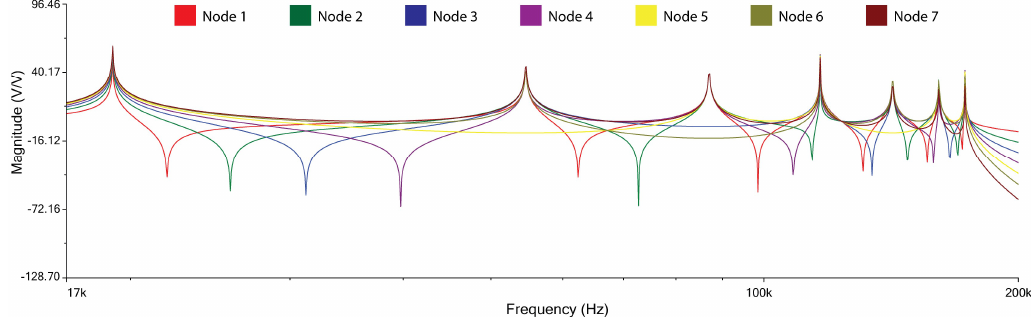
Figure 8. Magnitude plots vs frequency of the seven patterns readable by the seven nodes of the seven cells of the L–C L.N.